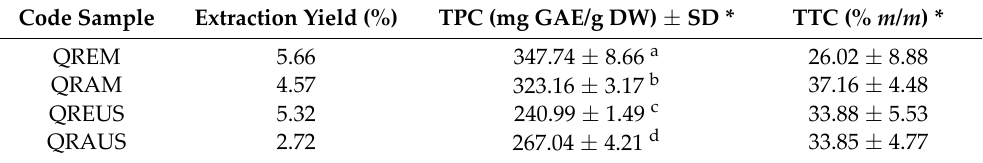
Table 1. The extraction yield, total content of phenolic compounds and tannins in oak bark extracts. Code Sample